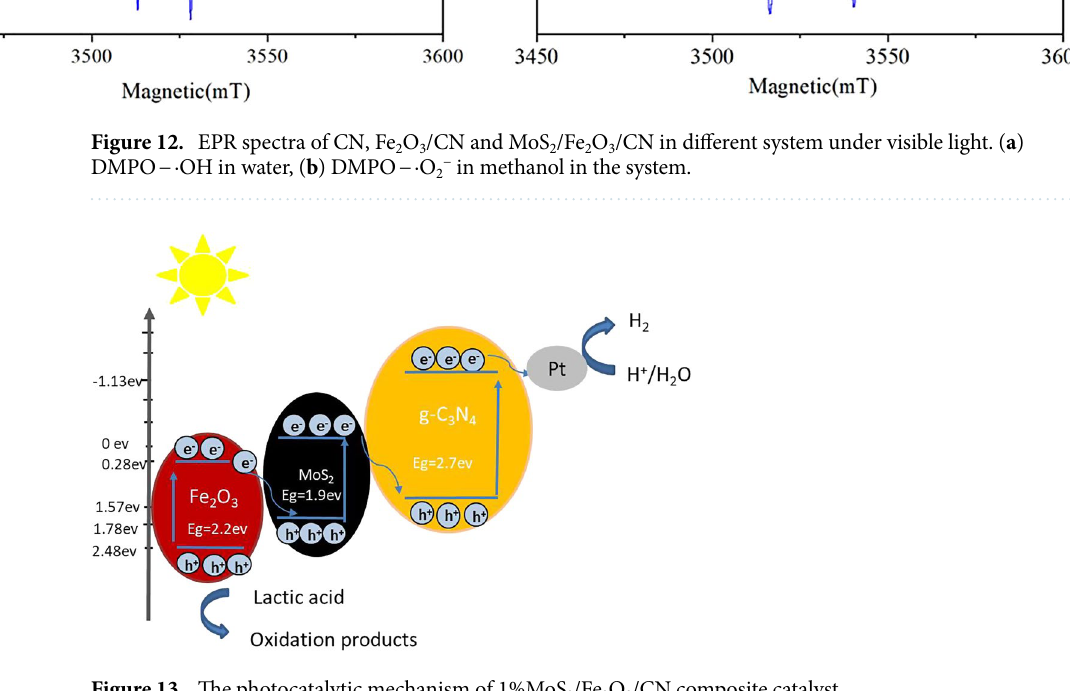
Figure 13. The photocatalytic mechanism of 1%MoS 2 /Fe 2 O 3 /CN composite